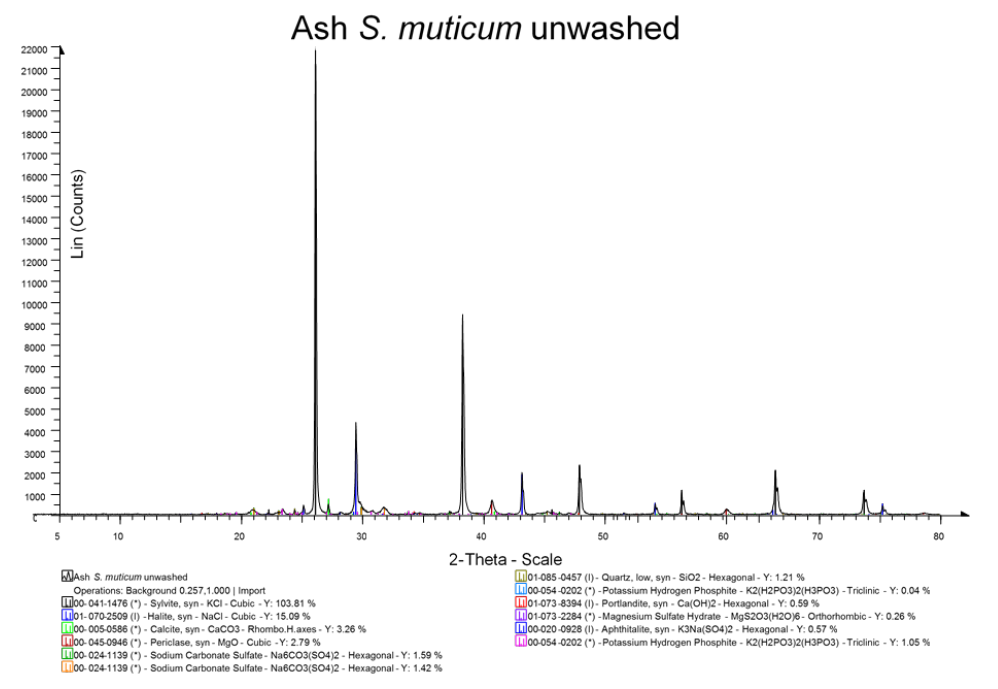
Figure 2 . XRD analysis of unwashed Sargassum muticum . Figure 2. XRD analysis of unwashed Sargassum muticum .